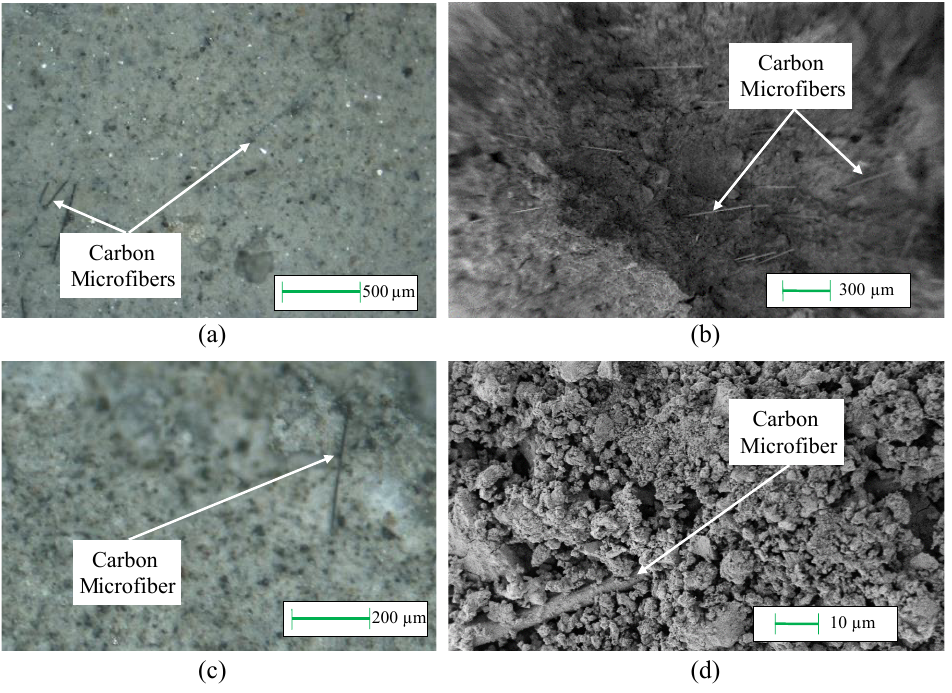
Figure 1. Micrographs of a hardened smart concrete fragment using ( a , c ) an optical microscope and ( b , d ) SEM at different magnifications.